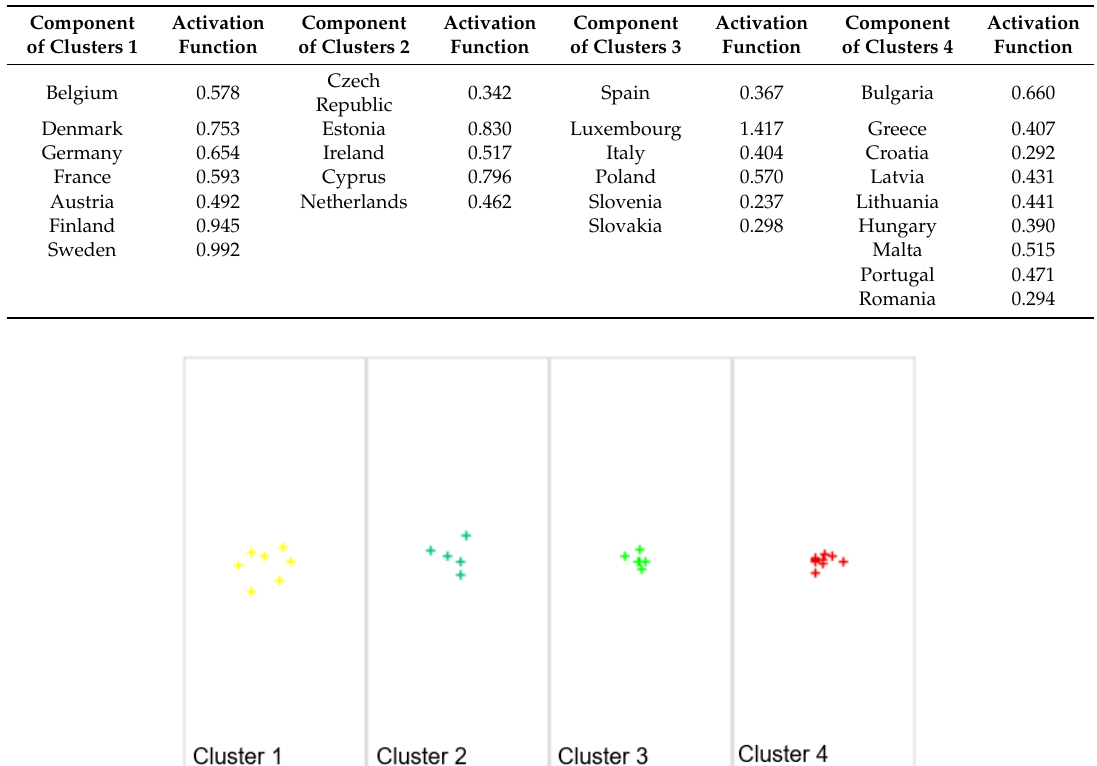
Figure 10. Topological map of clusters of similar EU-27 countries in terms of the values of sustainable energy indicators versus population size.